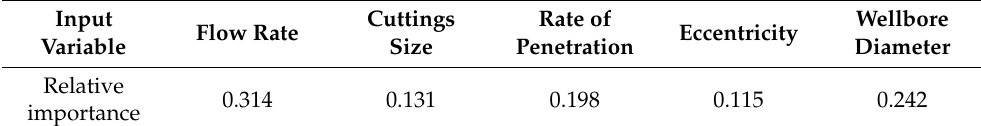
Table 5. Relative importance of the input variables.